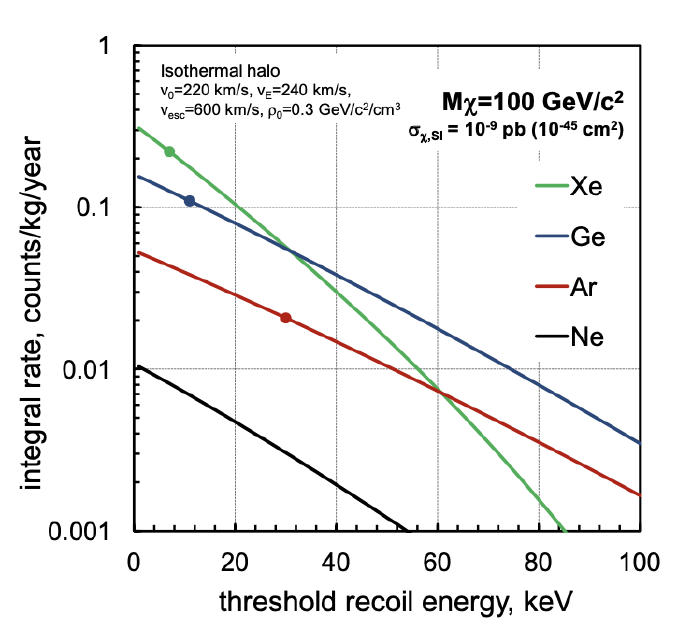
Figure 7: Event rates in units of counts per 10 kg of material per year of data-taking vs. energy threshold in keV for different target materials. Taken from [ 18